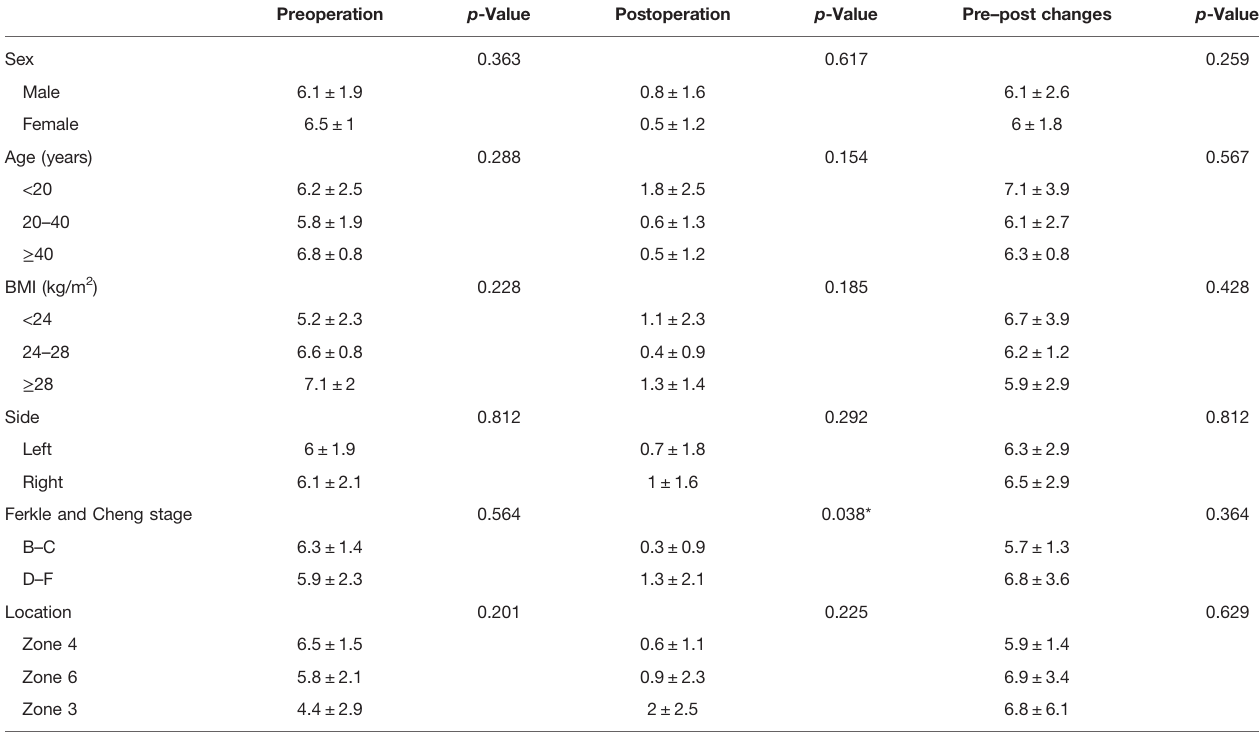
TABLE 4 | Other in fl uencing factors related to the VAS pain